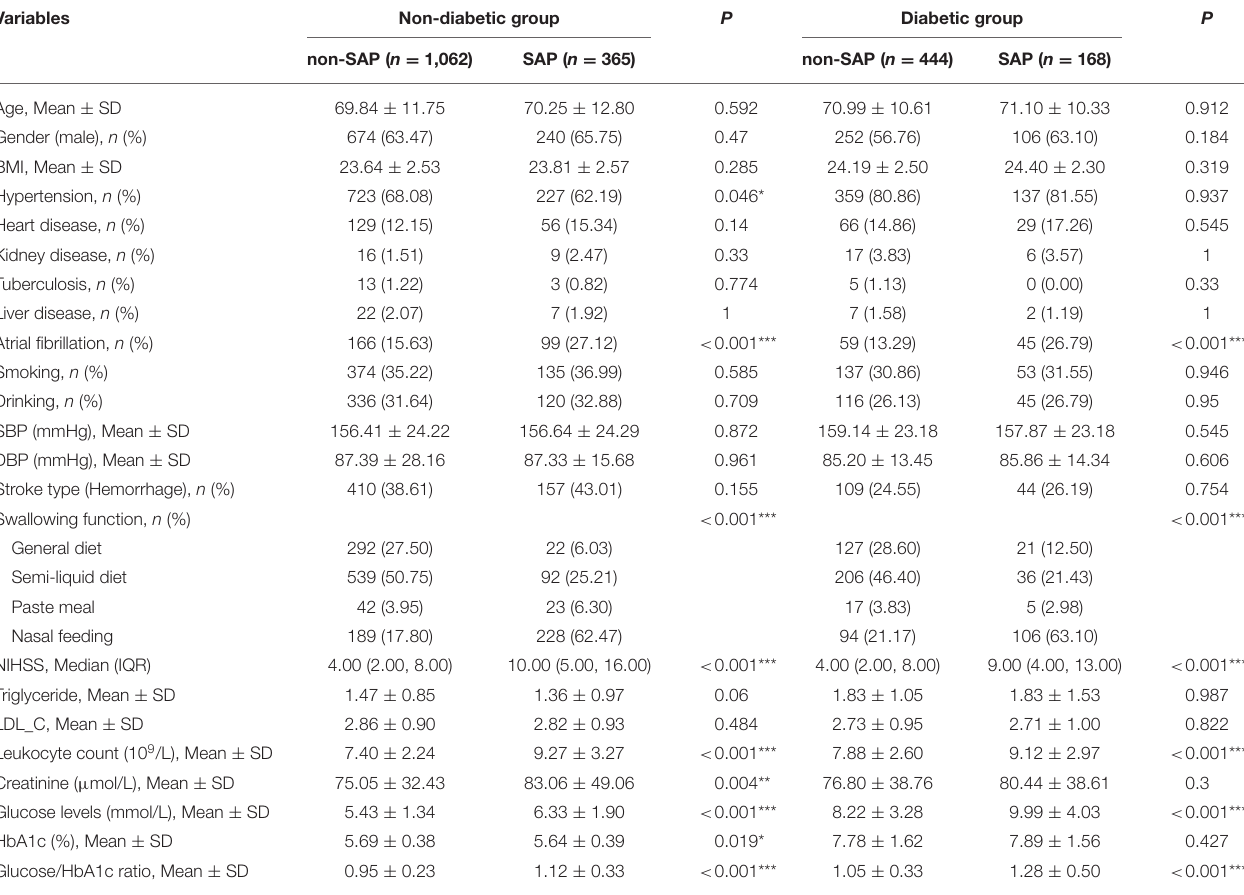
TABLE 3 | Comparison of characteristics between non-SAP and SAP groups stratified by the diabetic status.